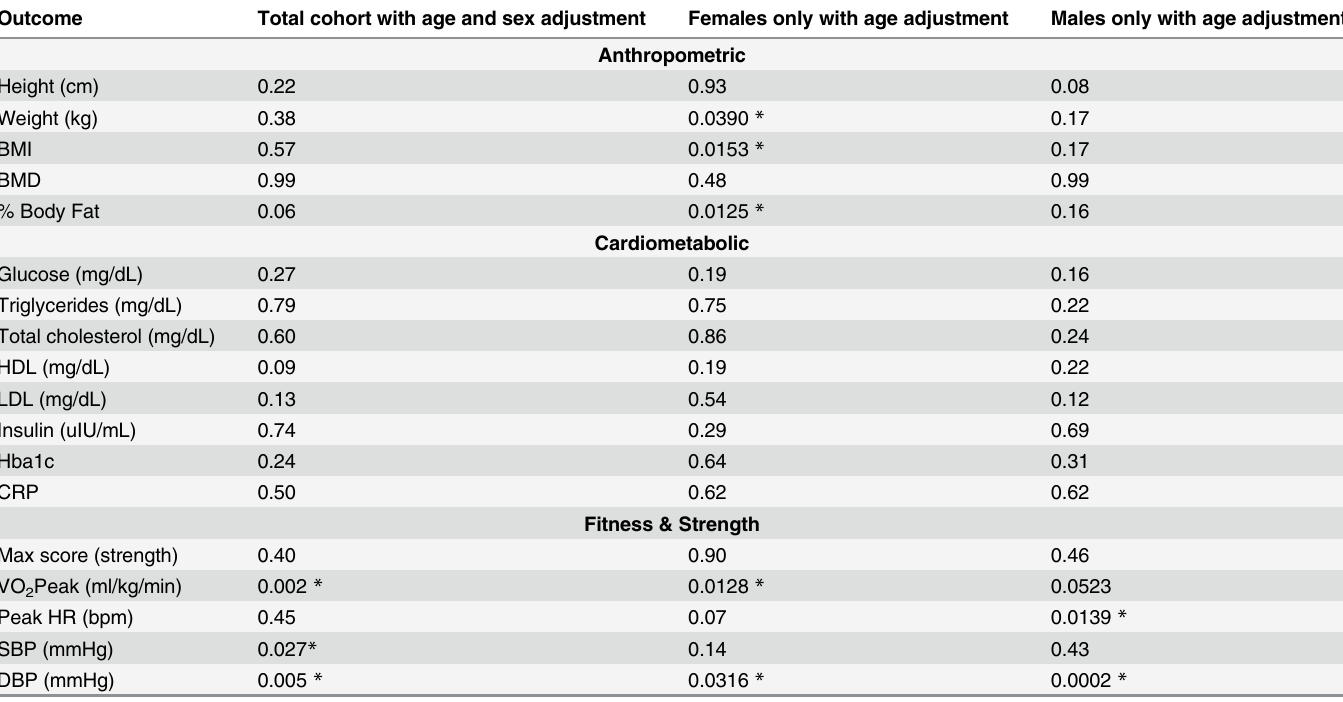
Table 2. Association between ACTN3 genotype and cardiometabolic traits. Outcome